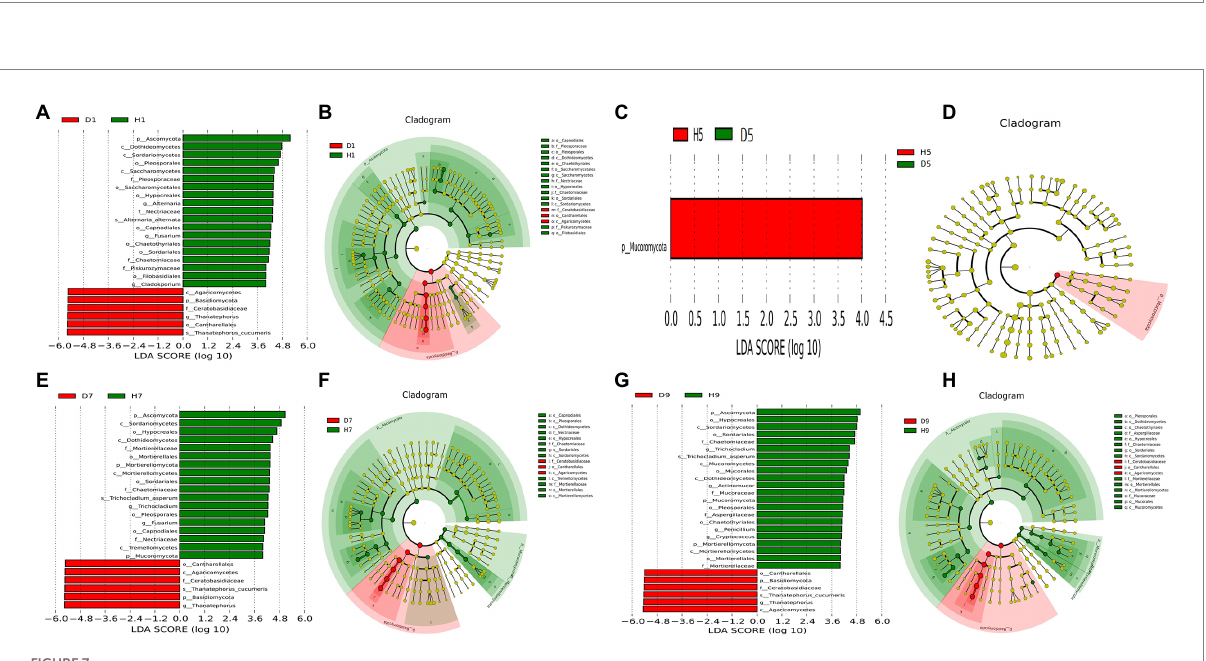
FIGURE 7 LEfSe analysis of fungi abundance between diseased and healthy samples of different disease severities. (A) , ( C ), (E) , ( G ) are LDA score identified the size of differentiation between diseased and healthy groups of 1, 5, 7, 9 disease severity, respectively, with a threshold value of 4. (B) , ( D ), (F) , ( H ) are the cladogram of microbial communities of 1, 5, 7, 9 disease severity,